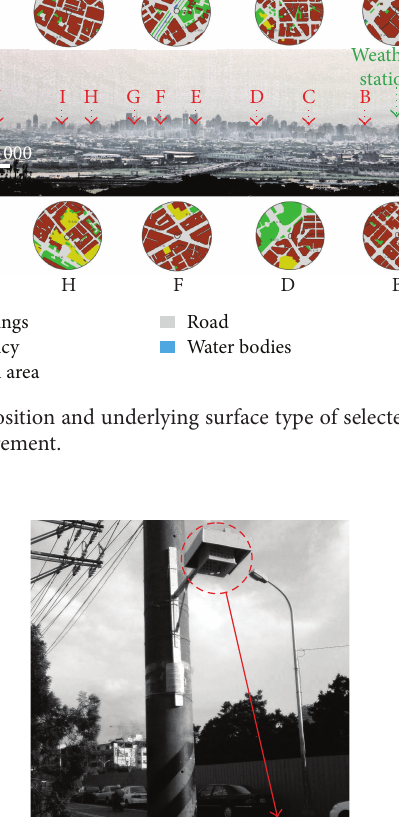
Table 1: Specifications of construction and air-conditioning system in a typical residential